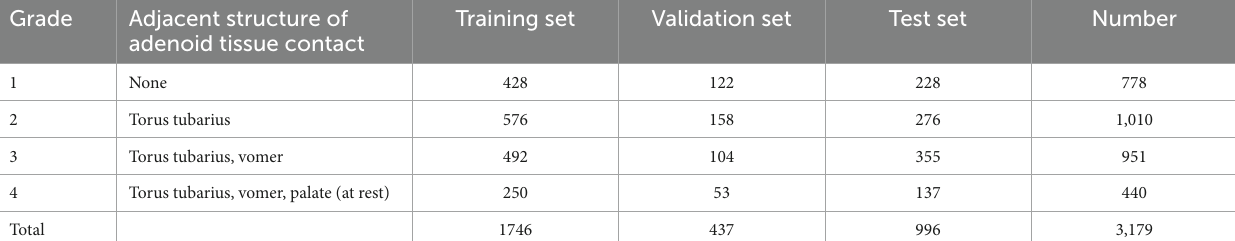
TABLE 1 Details of Parikh grading standard and data distribution of training set, validation set, and test set in SYSU-SZU-EA dataset. Grade